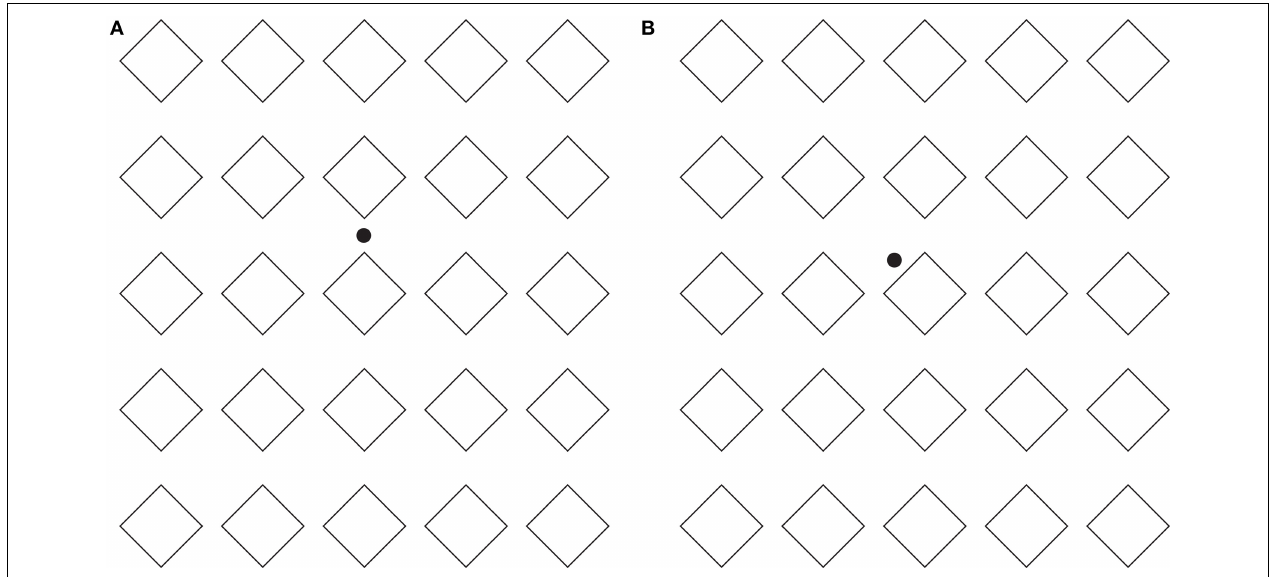
FIGURE 8 | The directional organization manifests long-range effects. For further details please see the text.